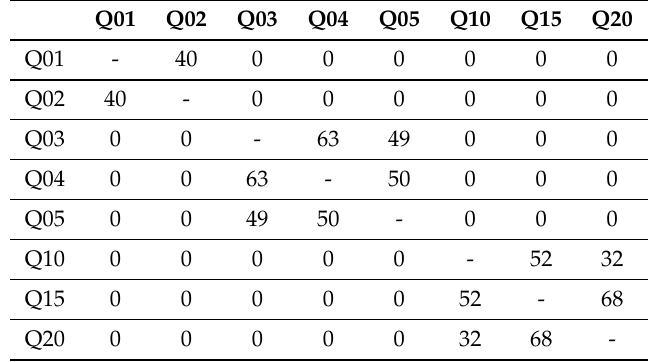
Table 13. Test results for similar Word documents with ssdeep.